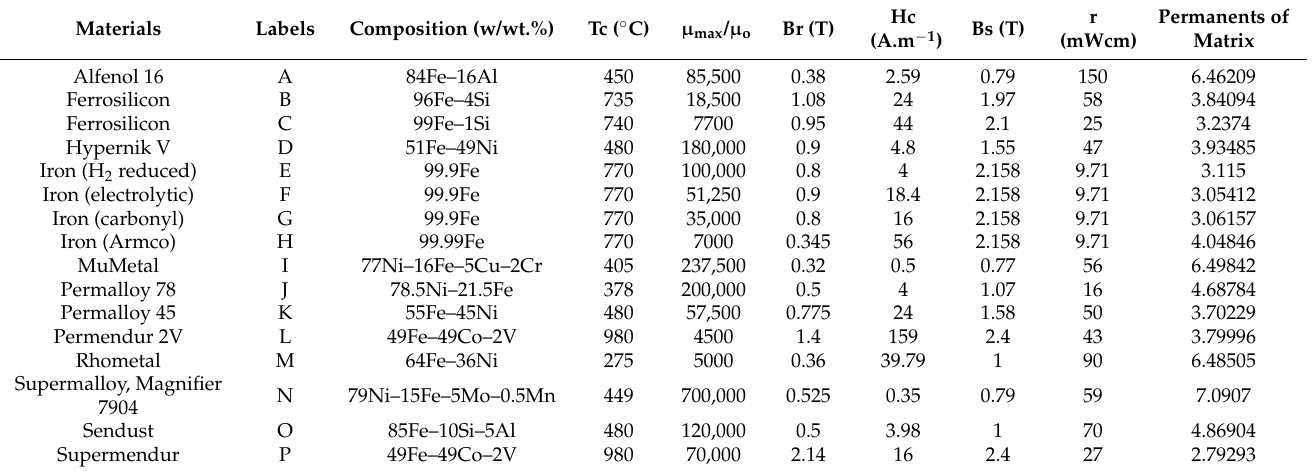
Table 9. Suitability Index and Ranking of enlisted Soft magnetic